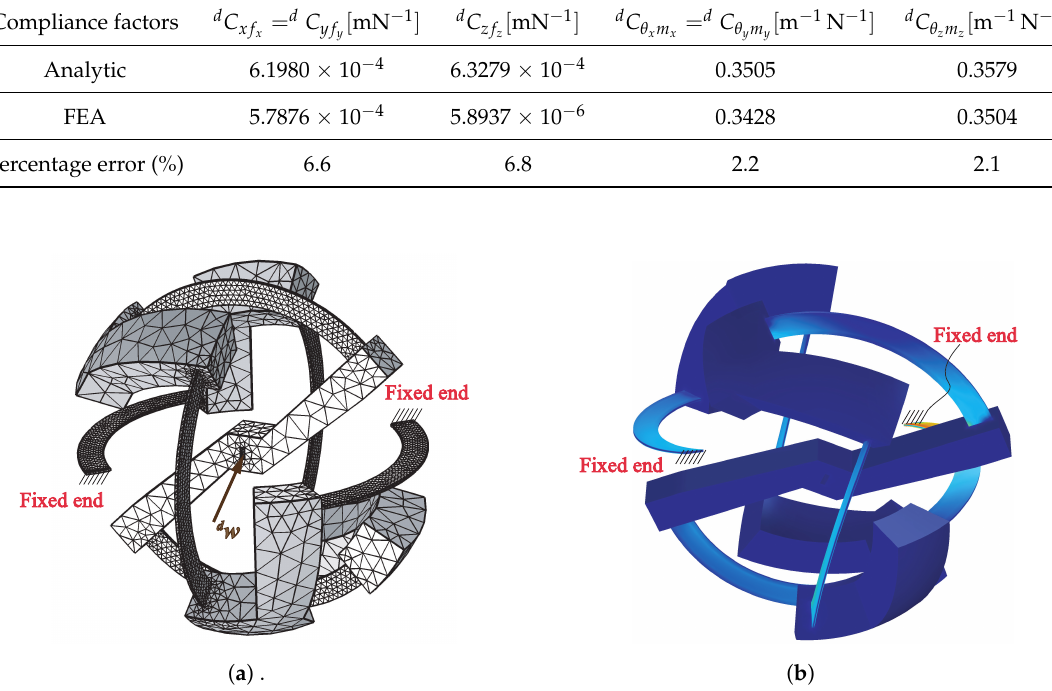
Figure 6. Finite Element Analysis of the spherical joint: ( a ) model mesh and boundary conditions, ( b ) deformed shape under the application of large loads (i.e., M yd = 2 Nm, F xd = 20